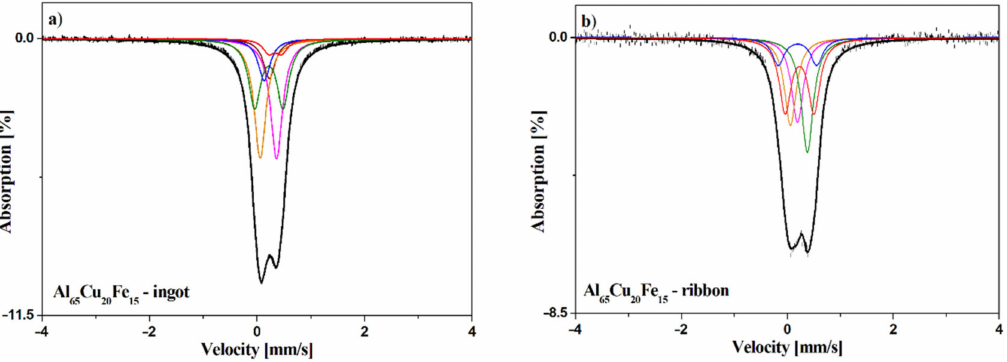
Figure 5. Mössbauer spectra for the alloys recorded for Al 65 Cu 20 Fe 15 ingot ( a ) and ribbon ( b ). The Mössbauer spectrum of the master alloy (ingot) contains four singlets and two quadrupole doublets. The values of the isomer shift of the first three singlets are typical for the Al 13 Fe 4 phase and the fourth singlet (Is = 0.14 mm/s) is connected with the Al 7 Cu 2 Fe phase [31]. The doublet with Is = 0.34 mm/s and Qs = 0.24 mm/s is related to iron located in body centered cubic structure of AlFe(Cu) [31]. According to the XRD results, the doublet with the highest contribution was associated with the quasicrystalline Al-Cu-Fe phase.